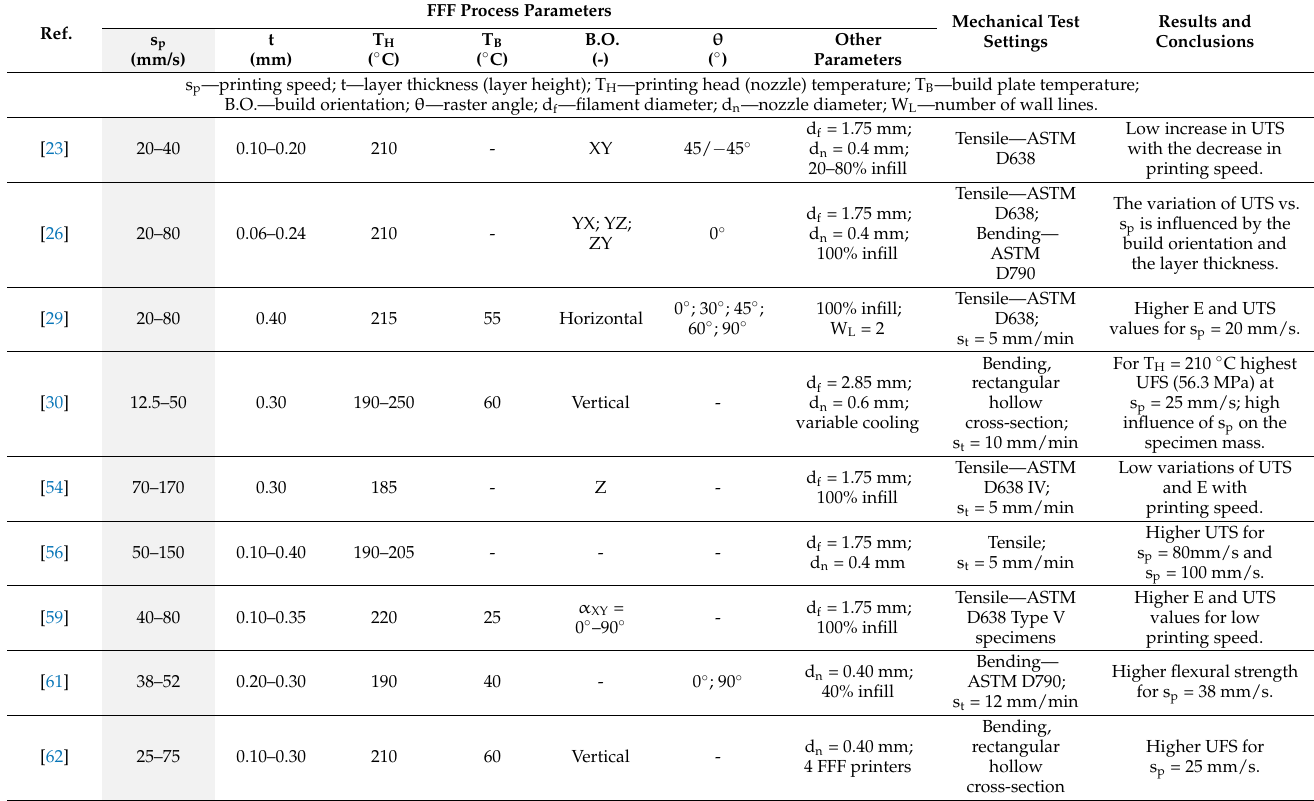
Table 3. The influence of the printing speed on the mechanical properties of FFF-printed